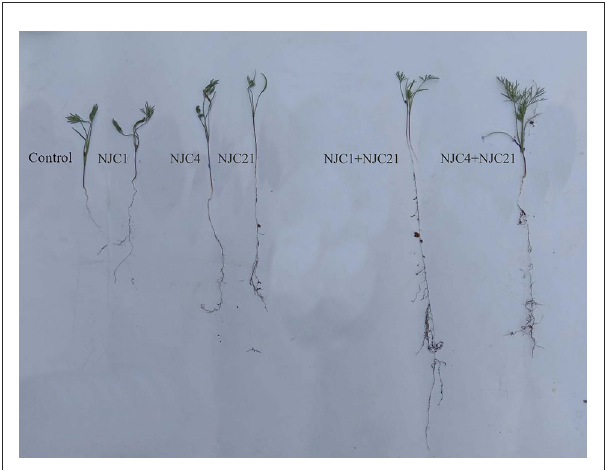
FIGURE7 Comparative root and shoot elongation in the plant after pot study.